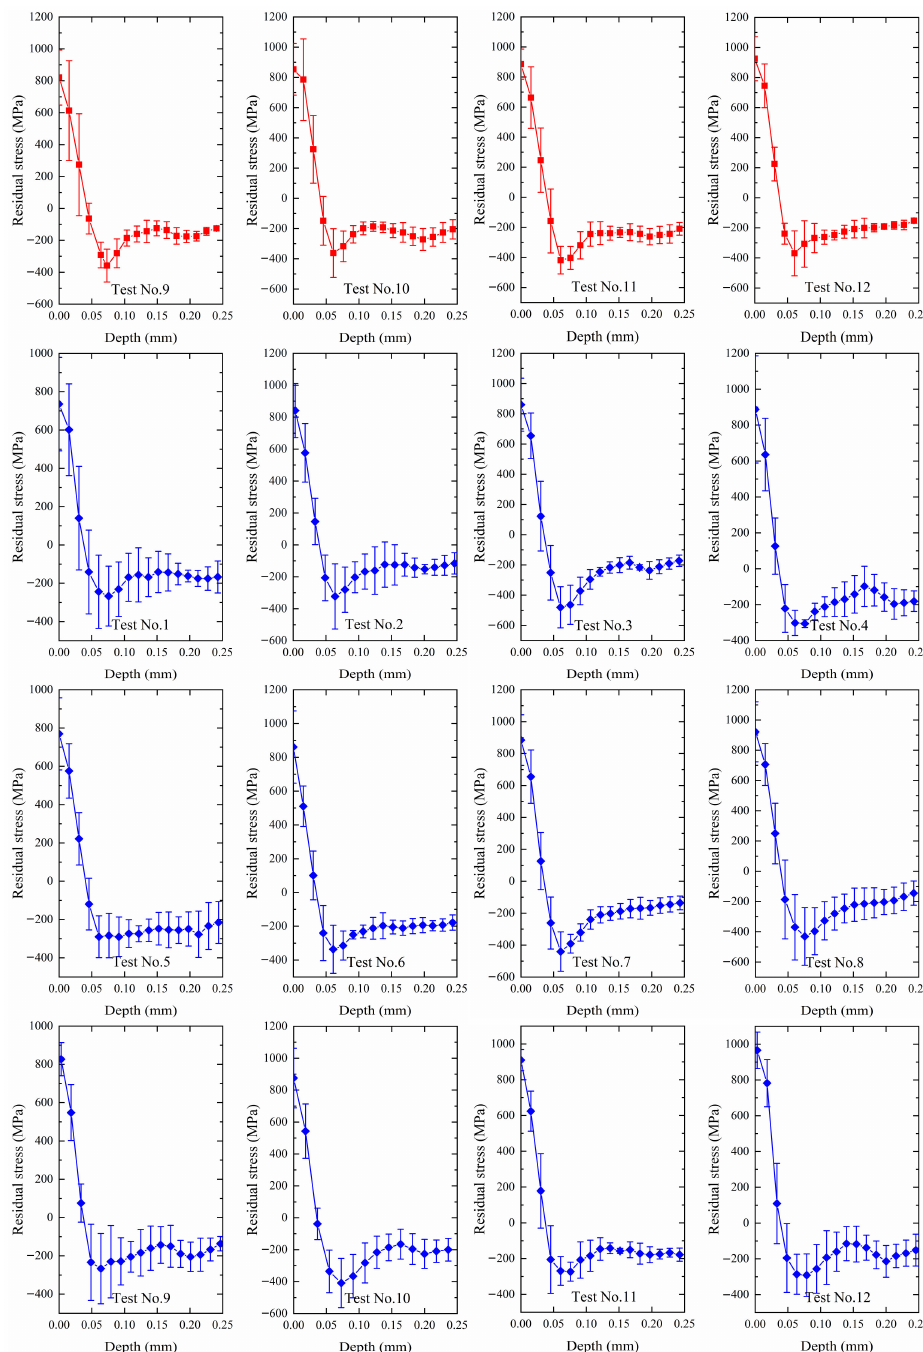
Figure A3. The residual stresses’ distributions extracted in 24